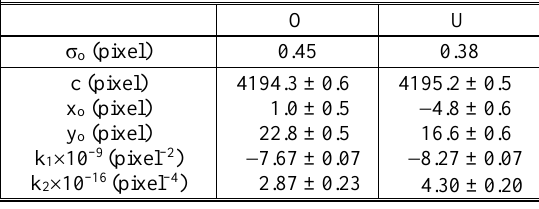
Table 2. Calibration results for Sony camera (14 images) O: ordered patterns; U: unordered patterns